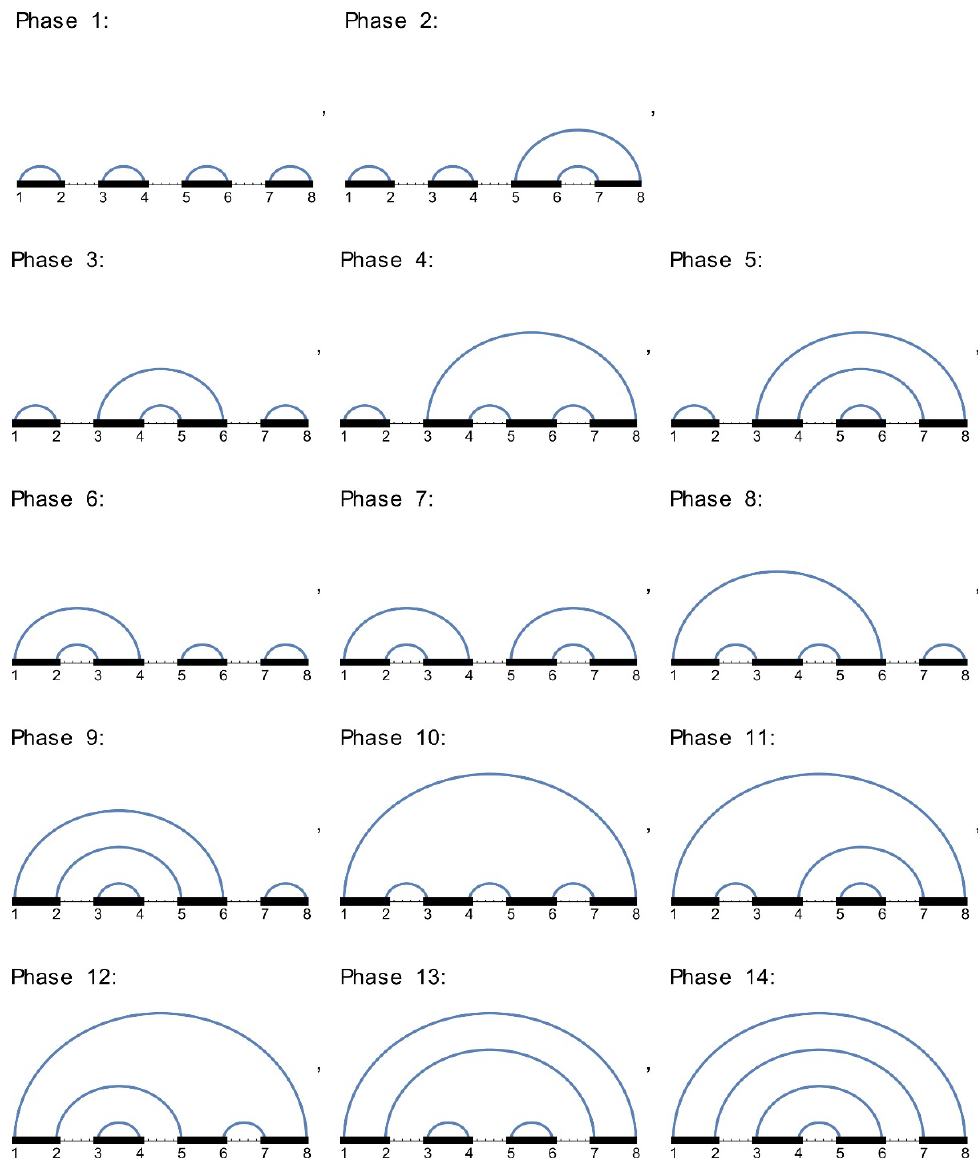
Figure 19 . Physical con(cid:12)gurations for n = 4 intervals. Note that out of the 4! = 24 con(cid:12)gurations that our counting would naively have suggested, there are only 14 physical ones, i.e. 14 ones where the curves do not intersect when projected to the same